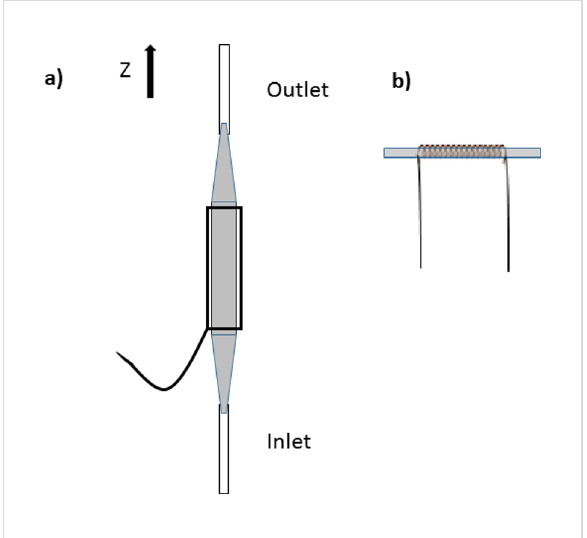
Figure 1: Graphical representation of (a) conventional flow cell with a saddle-shaped RF coil and (b) flow capillary with a solenoid coil.